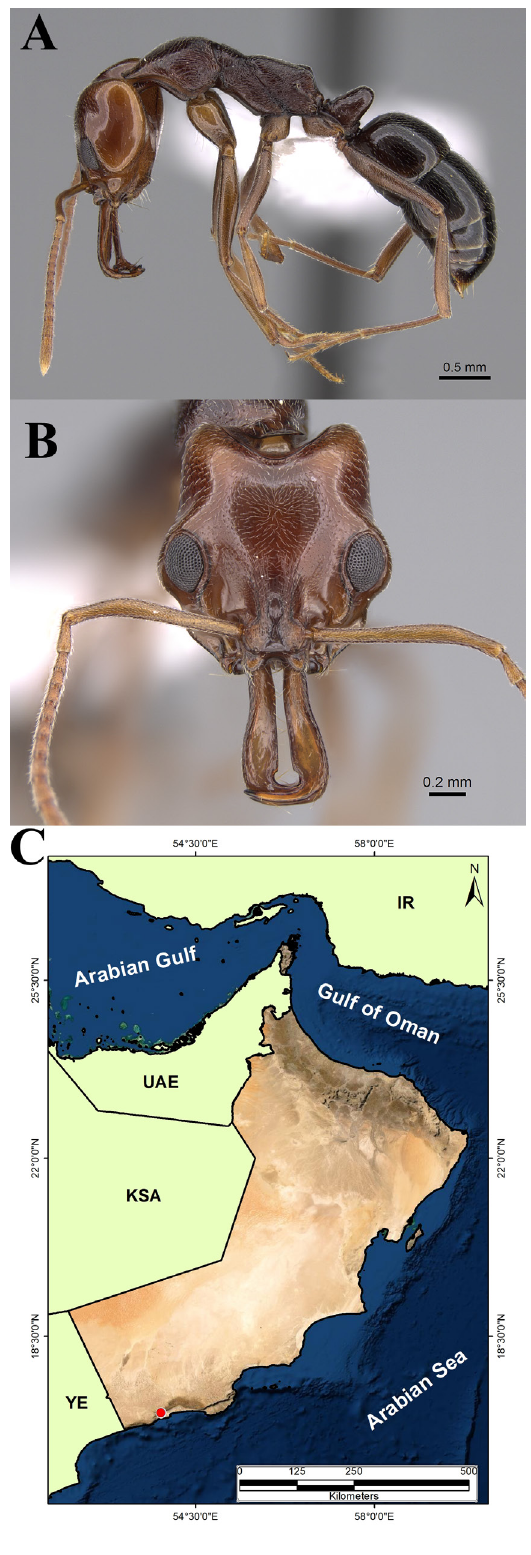
Fig. 52. Anochetus sedilloti Emery, 1884, worker (CASENT0922865, AntWeb.org (Michele Esposito)). A . Body in profile. B . Head in full-face view. C . Distribution